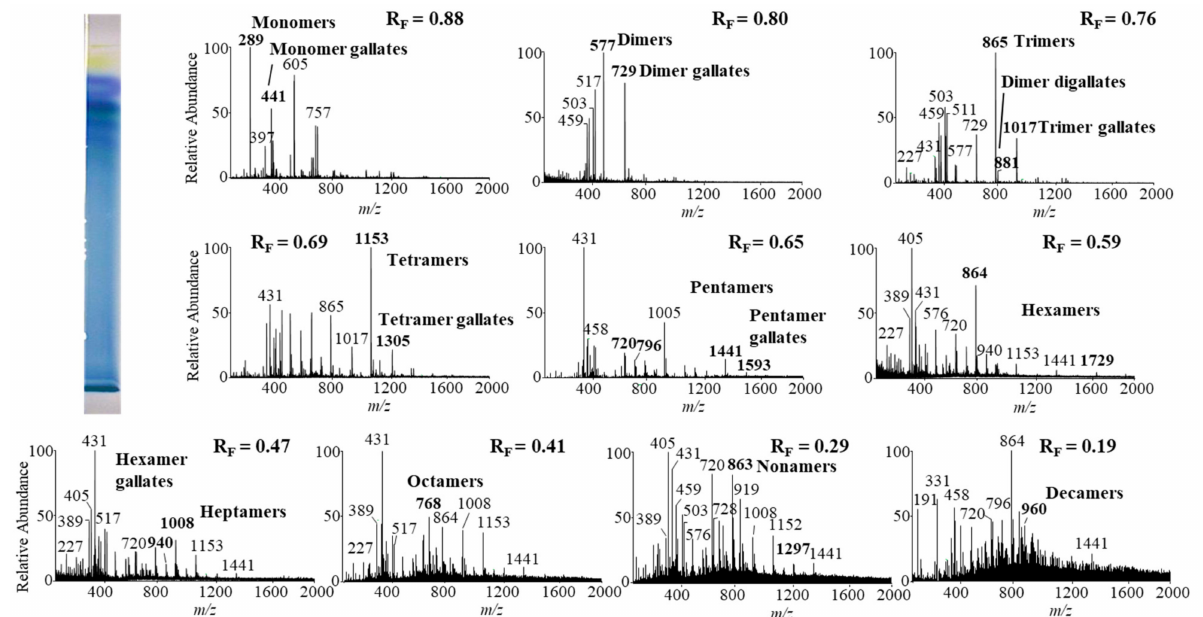
Figure 8. The MS spectra obtained by HPTLC—MS analysis of the STS from Bohemian knotweed rhizomes on HPTLC diol F 254S plate pre-developed and developed with acetonitrile. The bolded m/z values in the MS spectra belong to B-type proanthocyanidins and their gallates eluted from the underivatized part of the plate with acetonitrile–methanol (2:1, v/v ). A narrow derivatized (DMACA reagent) part of the plate with blue-colored proanthocyanidins zones was used for the proper positioning of the elution head of the TLC—MS interface.